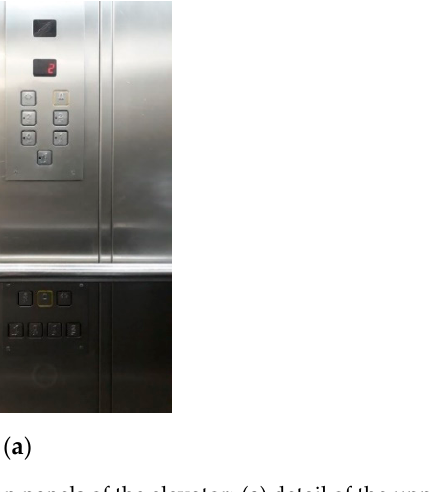
Figure 1. Button panels of the elevator: ( a ) detail of the upper, lower and emergency panels; ( b ) detail of the lower panel that will be covered by the IoT add ‐ on device.